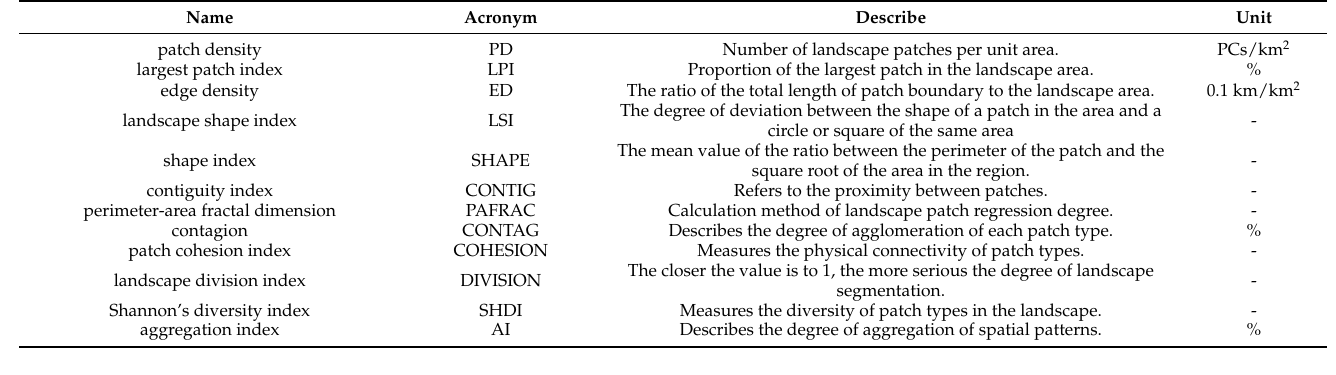
Table 1. The landscape pattern index.